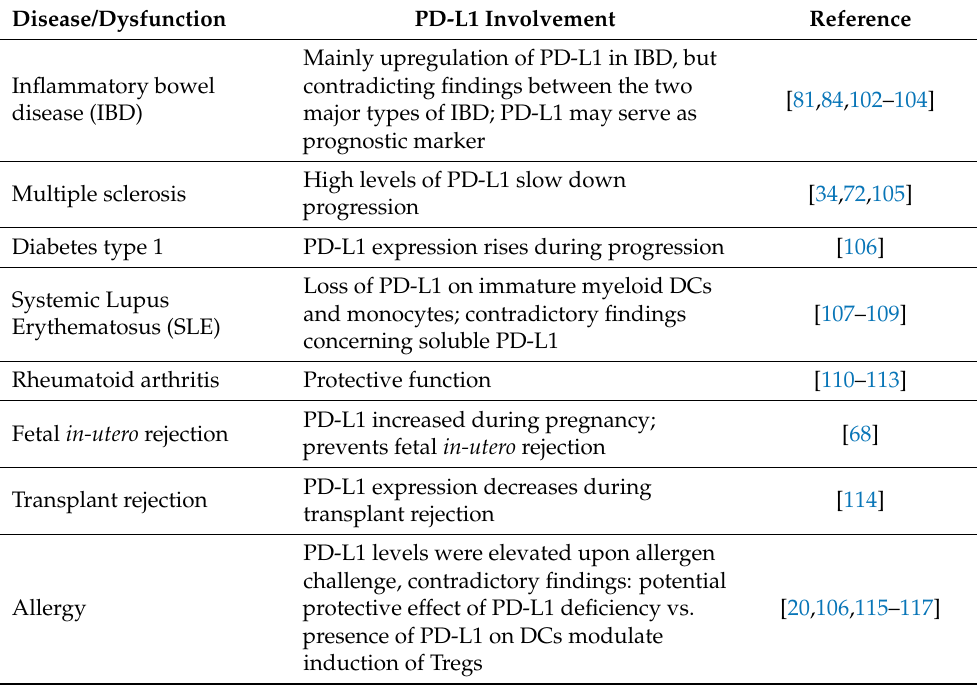
Table 2. Involvement of PD-L1 in Autoimmune Diseases and Allergies.